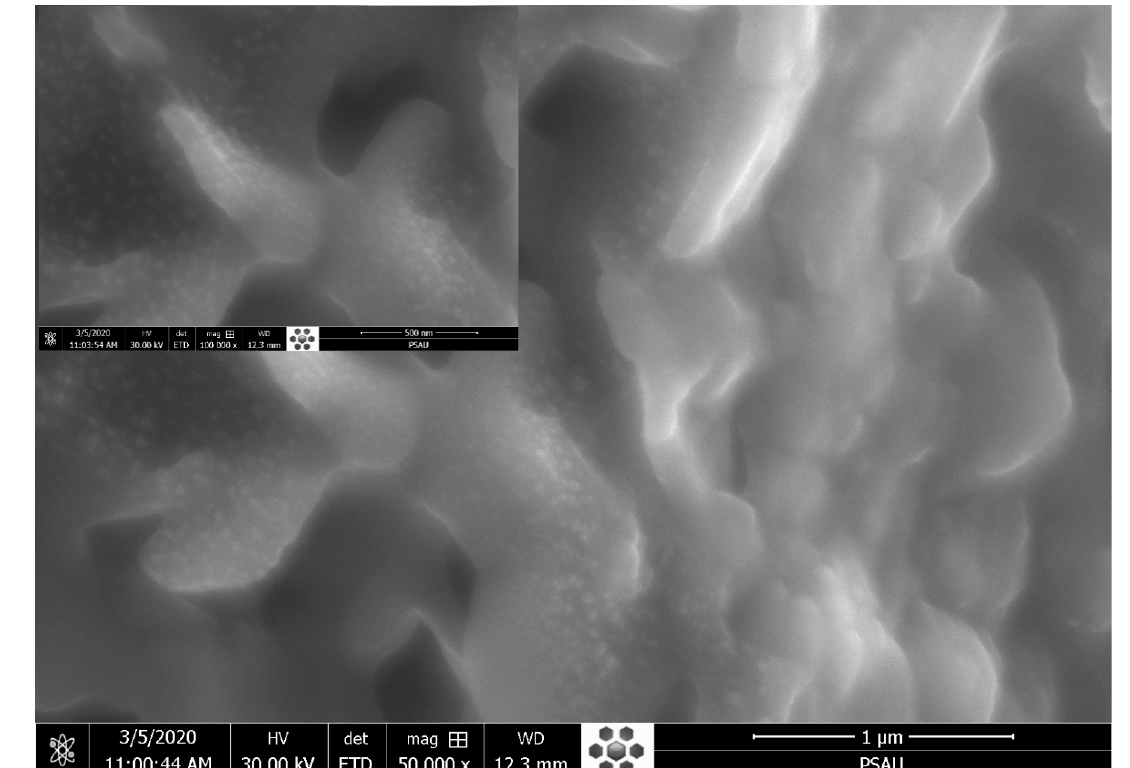
Figure 2. XRD patterns of pure ZnO, AMB-PEG and AMB-PEG-ZnO nanoparticles.